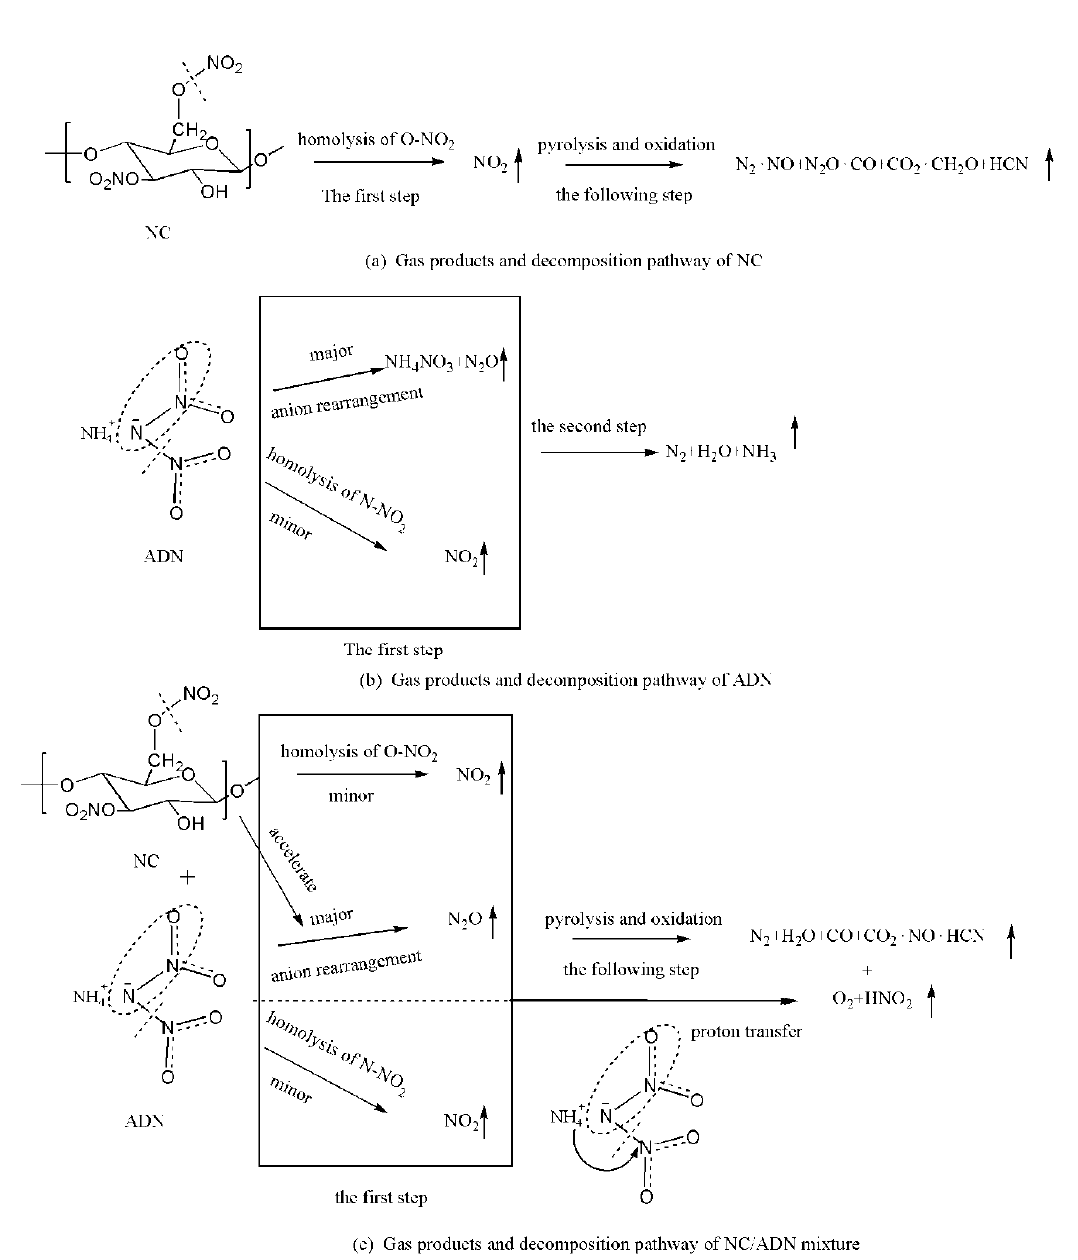
Figure 7. Decomposition pathway of NC, ADN and NC/ADN mixture. The initial decomposition of NC began with the hemolysis of the O-NO 2 bond to form NO 2 gas first, then N 2 O appeared as the secondary product of NO 2 reacted with the residue of NC. However, N 2 O was the significant product in the first decomposition step of and; hence, the N 2 O formation in the initial stage can be completely ascribed to the decomposition of ADN. It is hard to discriminate the origin of NO 2 in the initial decom- position stage of the NC/ADN mixture, because both ADN and NC can produce it from the breakup of N-NO 2 or O-NO 2 , respectively. For ADN alone, no O 2 and HNO 2 formed; however, these two oxidative gases formed for the NC/ADN mixture. In the initial de- composition stage of the NC/ADN mixture, NC did not change the major gas products of